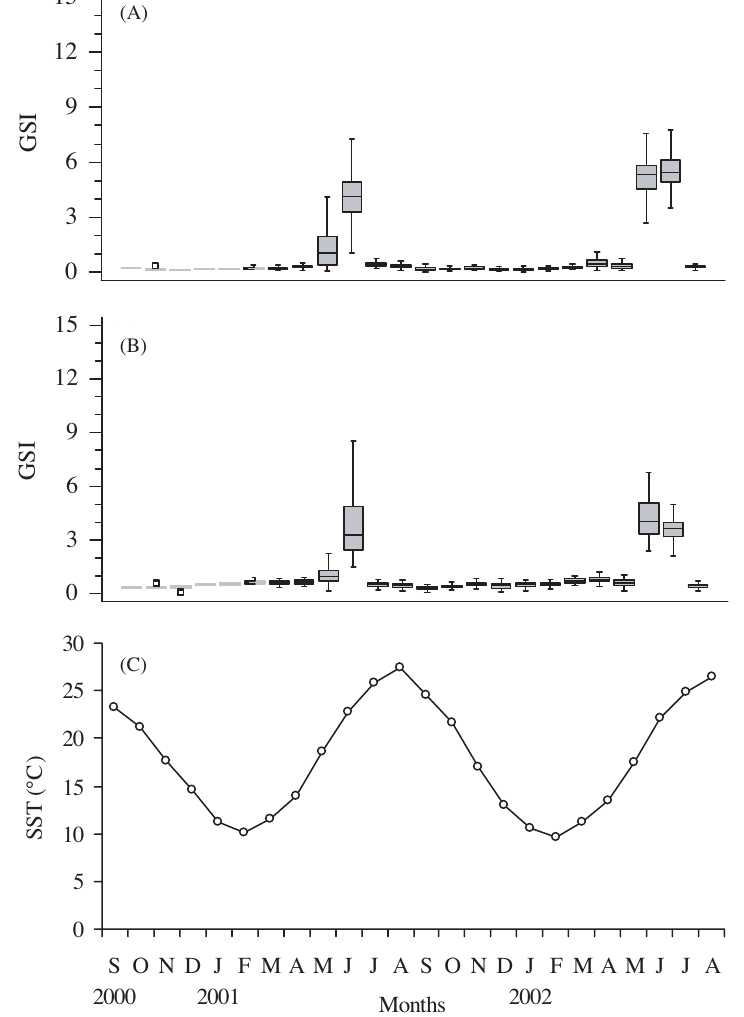
sample medians; the squares indicate outliers. (C) Monthly variation of mean sea surface temperature (SST, °C) in the northern Aegean Sea (September 2000-August